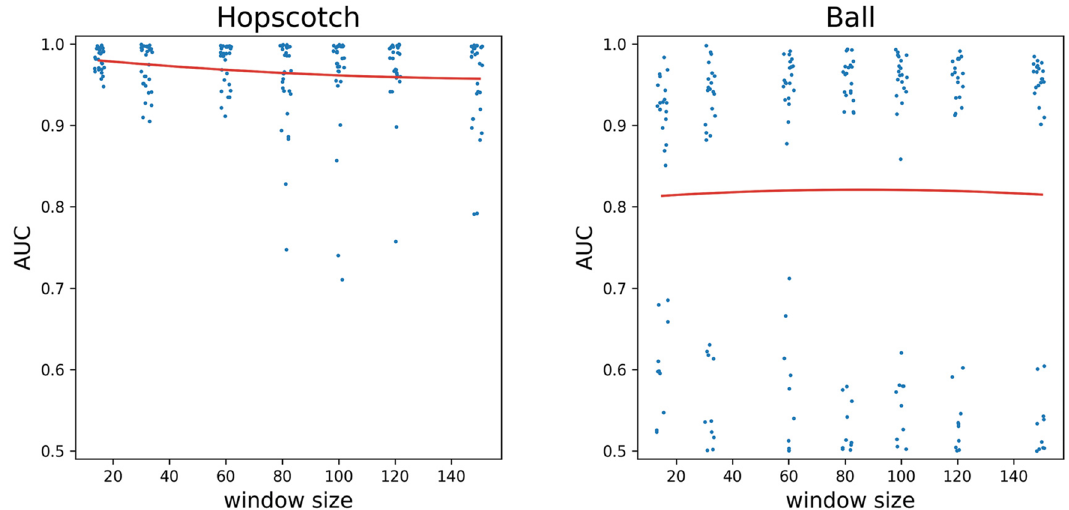
Figure 1. Playful activities with the highest AUC values, AUC values as a function of the window size. Quadratic curves fitted (Hopscotch: adj. R 2 = 0.240, Ball: adj. R 2 = 0.044). A small random jitter was added to the window sizes for better